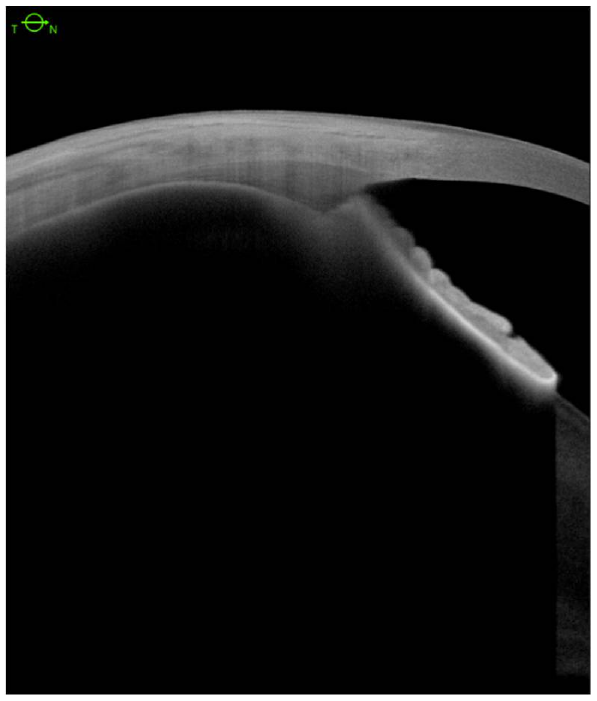
Figure 1. Anterior segment swept-source OCT with normal ciliary body structure.